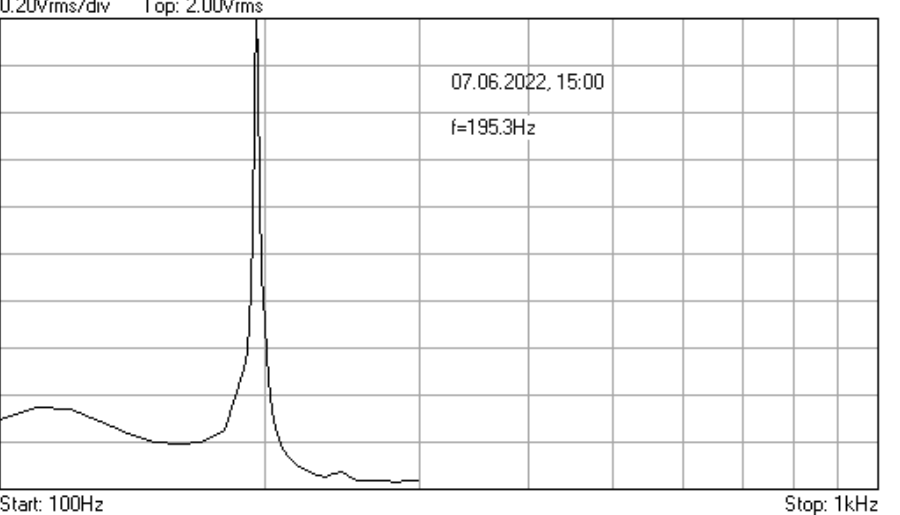
Figure 6. Frequency response function for additional mass 0.06 kg, recorded at the initial moment.